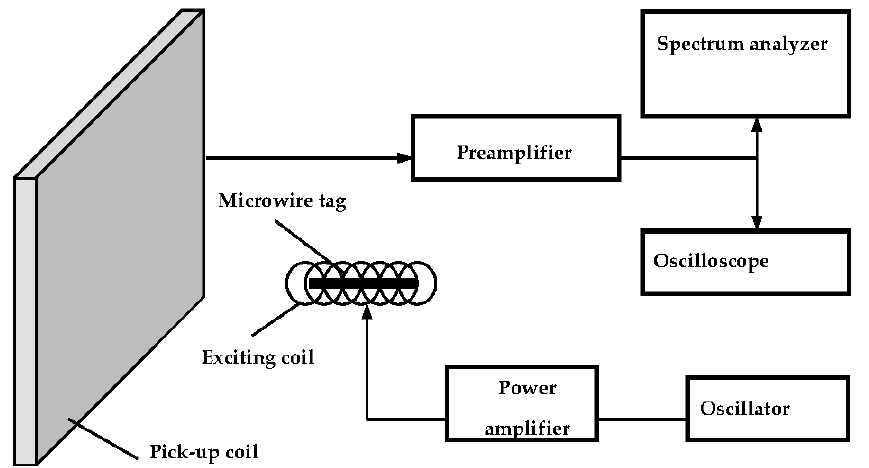
Figure 1. Scheme of experimental set-up designed to detect the electromagnetic signals of the magnetic labels. Reprinted with permission from [47].